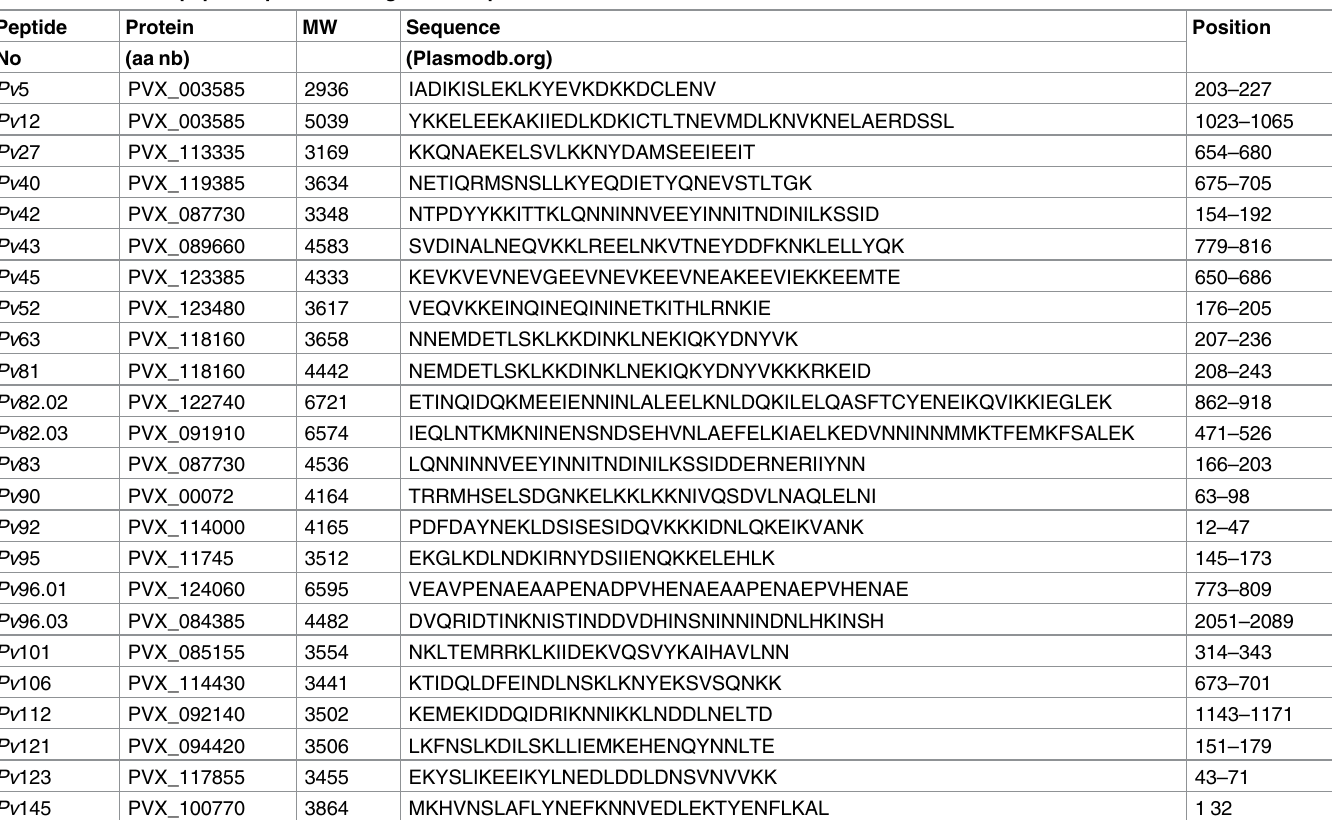
Table 1. Coiled coil peptides protein of origin and sequences.